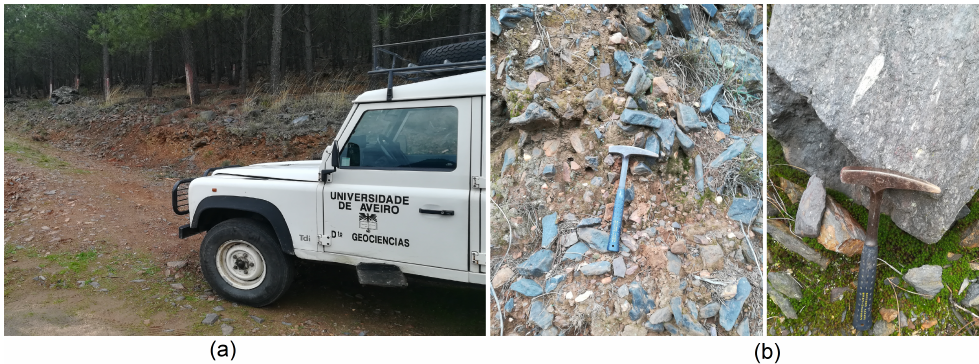
Figure 3. Hematite ore sample extraction area, located on the slopes of Cabeço de Mua, Moncorvo: ( a ) sample collection site along a 100 m stretch; ( b ) hematite ore in